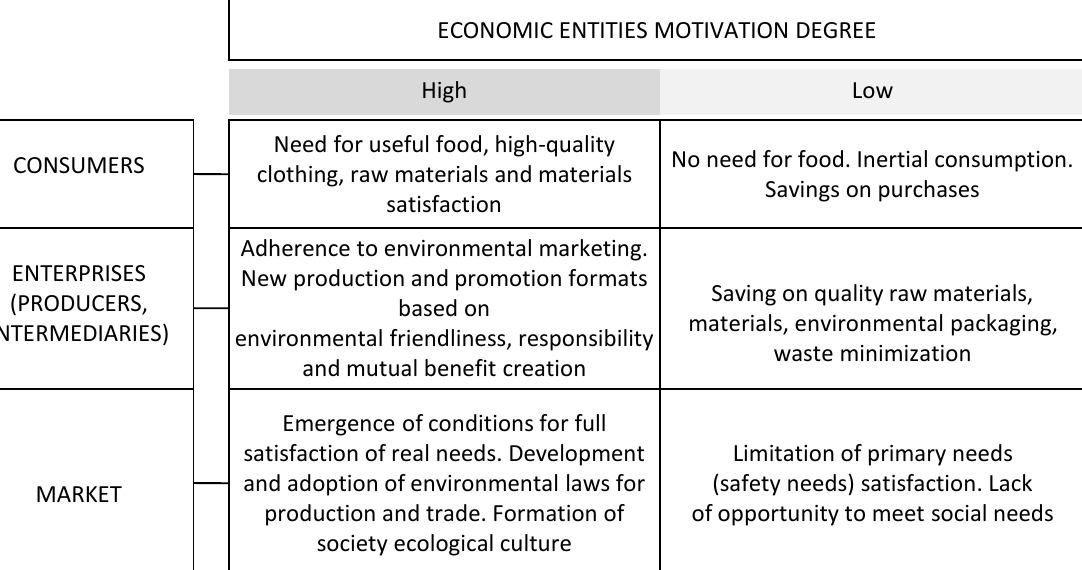
Source: Developed by authors Kima, Jungsun, Songb, Hak Jun, and Lee, Choong-Ki (2016), Mahmoud, Blankson, and Hinson